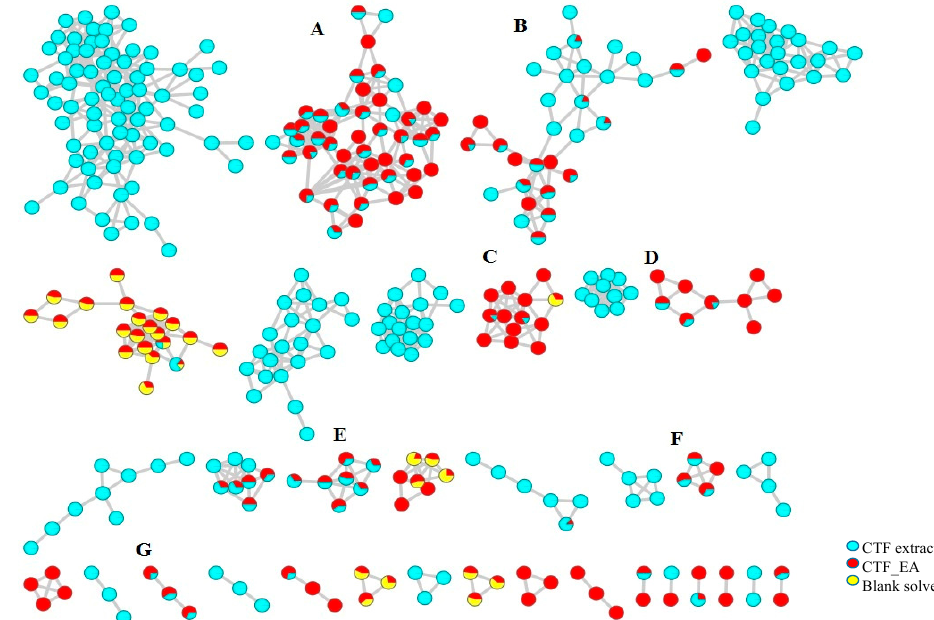
Figure 7. Full visualization of the molecular network in negative ion mode of the flower extract (CTF) and ethyl acetate fraction (CTF_EA) of C. ternatea . The annotated classes of metabolites are: